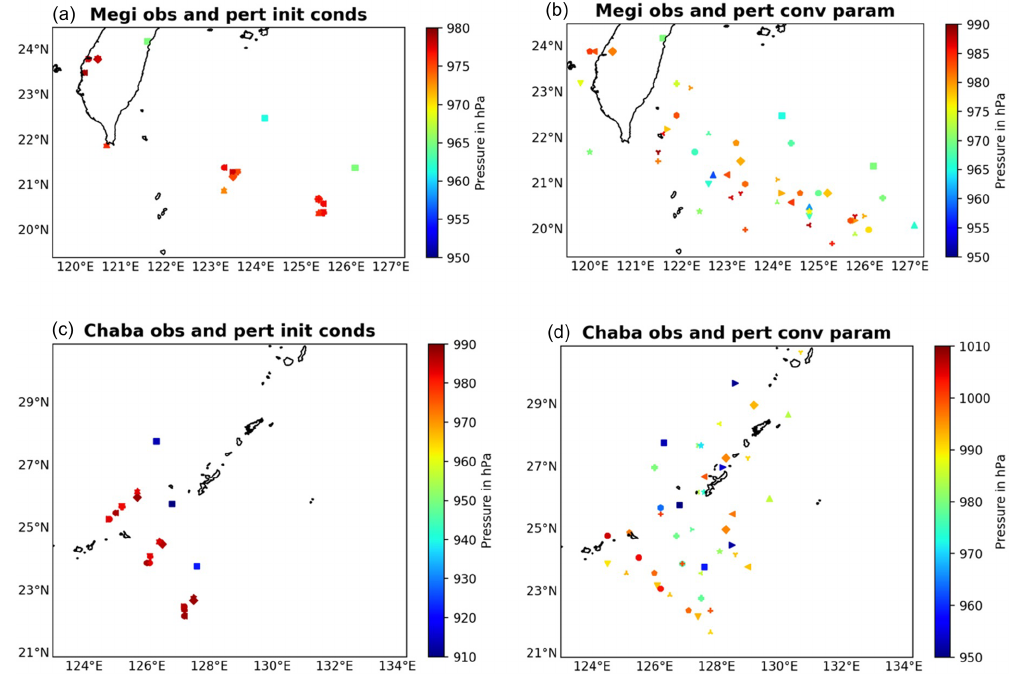
Figure 3. Schematic ensemble of cumulus cloud (a, c) and bulk convection scheme (b, d) showing the main components of a bulk convection scheme: trigger, updraft, downdraft, entrainment, detrainment, closure, conversion of cloud water to rainwater, precipitation and evaporation, and subsidence. Schemes based on Arakawa and Schubert (1974, a, c ) and Bechtold (2019, b, d ).